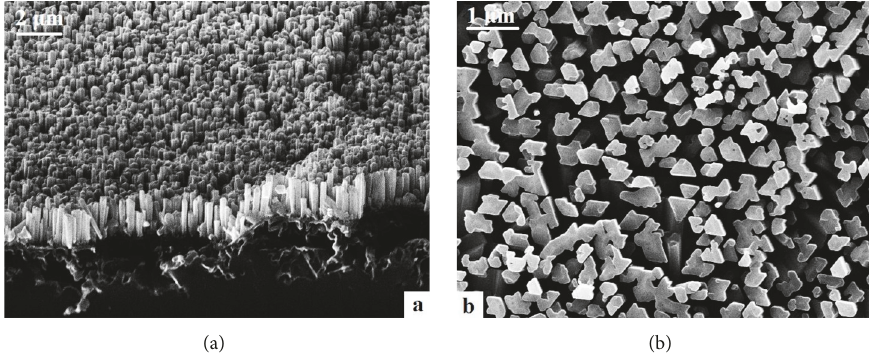
Figure 2: SEM images of GaN NWs grown on SiC/Si(111) substrate: (a) tilted by 20 0 cross section view; (b) top-view.